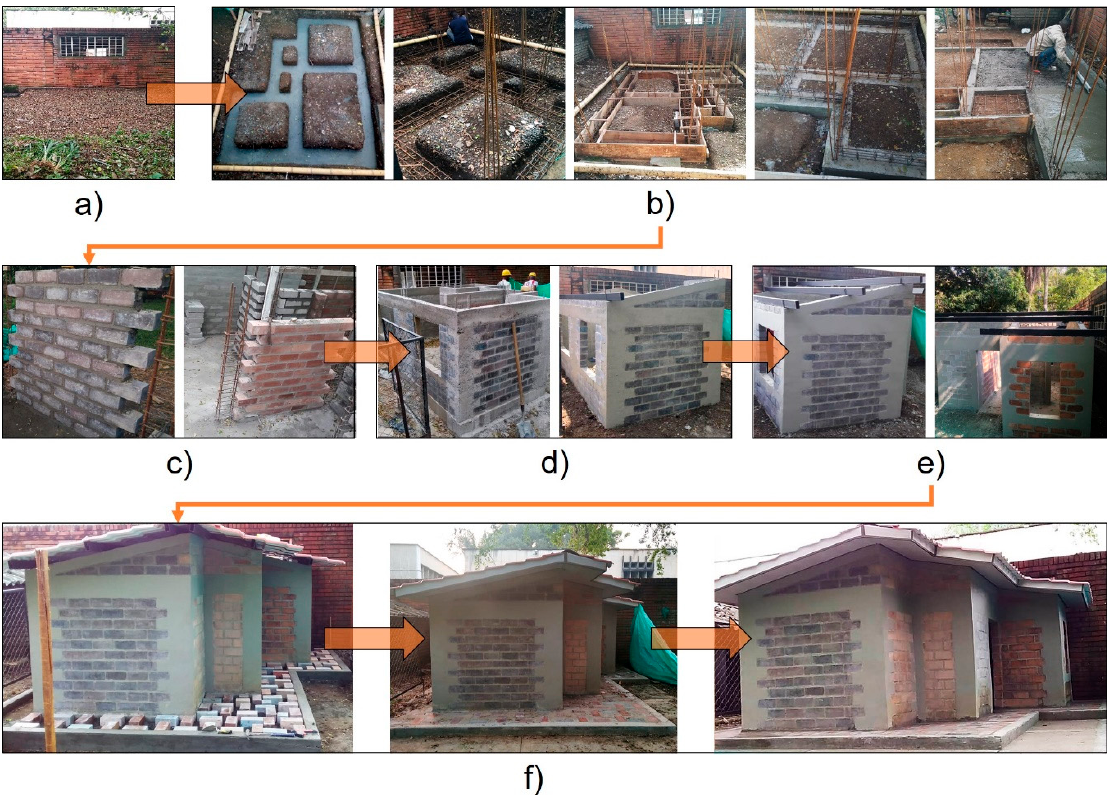
Figure 7. Construction process of the eco-house prototype: ( a ) adaptation of the terrain, ( b ) casting of concrete foundations and floor, ( c ) wall construction, ( d ) casting of confining columns and beams, ( e ) installation process of roof, and ( f ) construction of platforms and final finishing of the eco-house prototype.